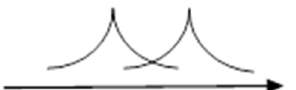
Figure 2. Partially overlapping photonic